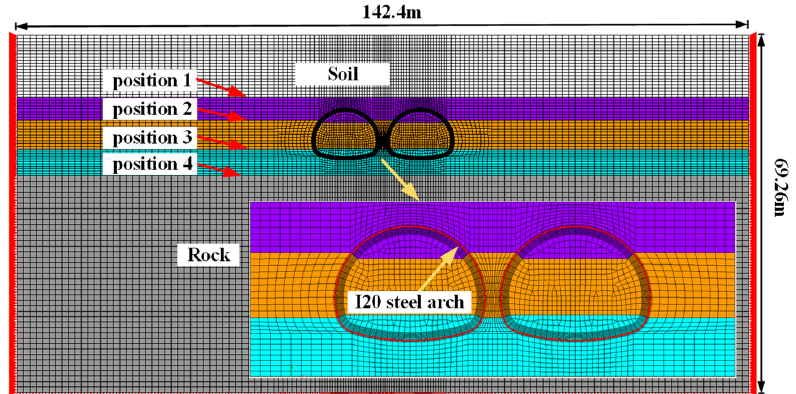
Figure 9. Position of soil-rock interface and finite element model of ultra-small clearance tunnel. Table 1. Calculation material parameters.